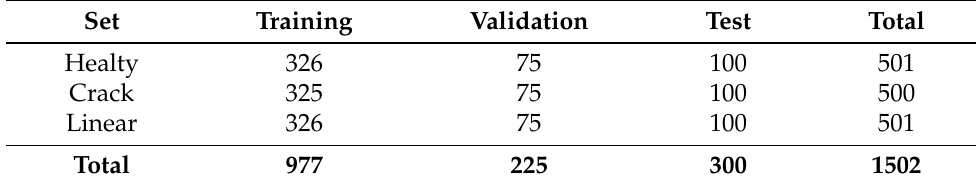
Figure 8. The dataset is composed of an equal number of samples for each class, and it is divided into training, validation and test sets. Table 1. Number of samples in the considered